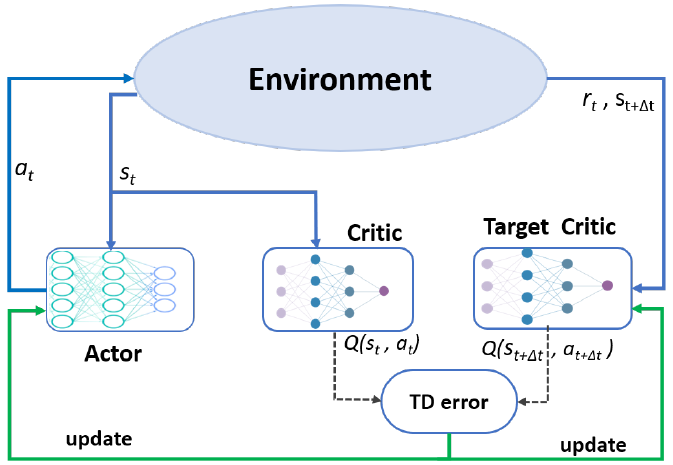
Figure 2. Architecture of the actor-critic learning